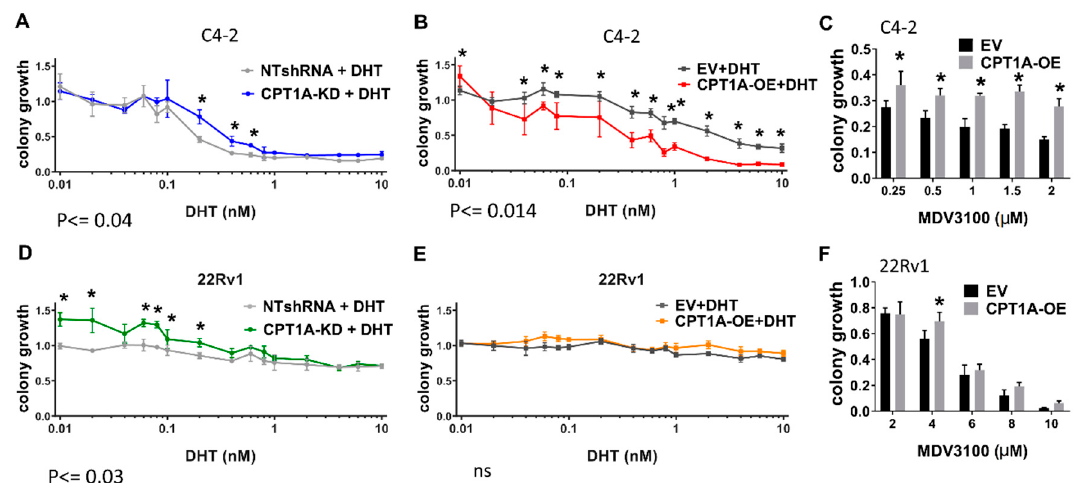
Figure 4. Clonogenic growth of CPT1A -KD and CPT1A -OE cells in the presence of androgens or anti-androgens. Cells were grown in media containing FBS supplemented with increasing DHT (androgen) or MDV3100 (enzalutamide) concentrations. Colonies were analyzed by normalizing to vehicle treatments. Significant results between conditions are indicated: ( A – C ): Clonogenic growth of C4-2 CPT1A -KD and control cells ( A ) and C4-2 CPT1-OE and control cells ( B ) in presence of increasing amounts of DHT, n = 4 per group. ( C ) Clonogenic growth of C4-2 CPT1-OE and control cells with increasing concentrations of MDV3100, n = 4 per group, * p < 0.01. vs. control. ( D – F ): Clonogenic growth of 22Rv1 CPT1A -KD and control ( D ) and 22Rv1 CPT1-OE and control ( E ) with increasing amounts of DHT, n = 4 per group. ( F ) Clonogenic growth for the 22Rv1 CPT1-OE and EV control cells with increasing concentrations of MDV3100, n = 4 per group, * p = 0.01 vs. control.